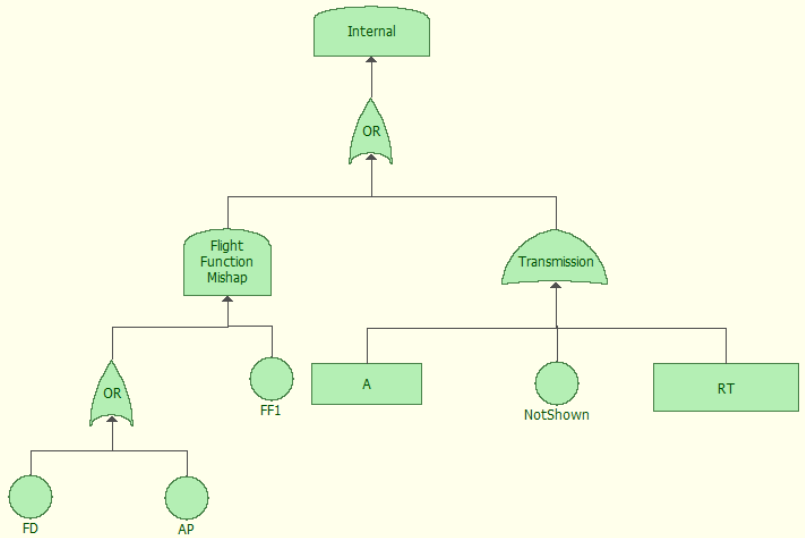
Figure 3. Internal component first level fault tree